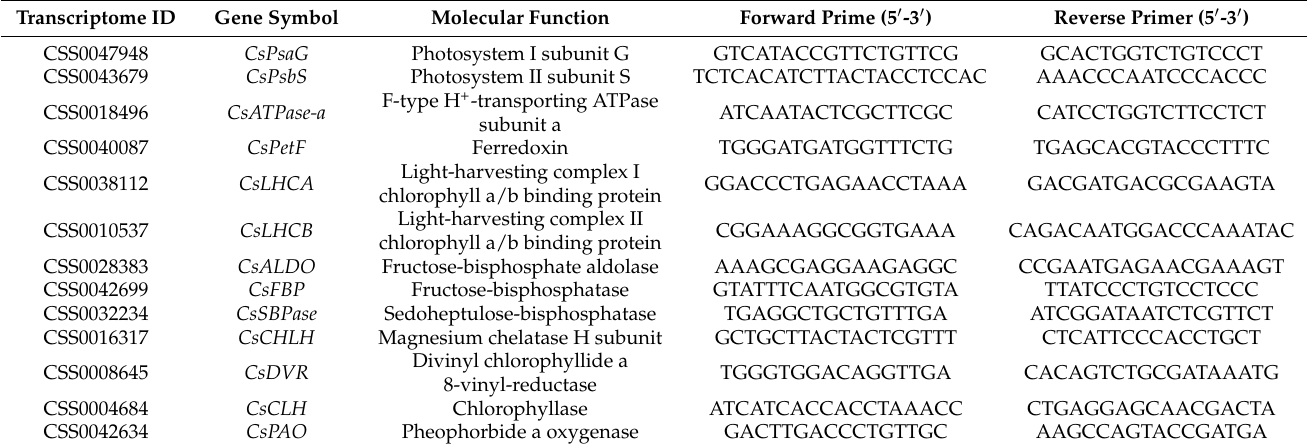
Table 3. Primer sequences of photosynthesis and Chl metabolism related genes for RT-qPCR.